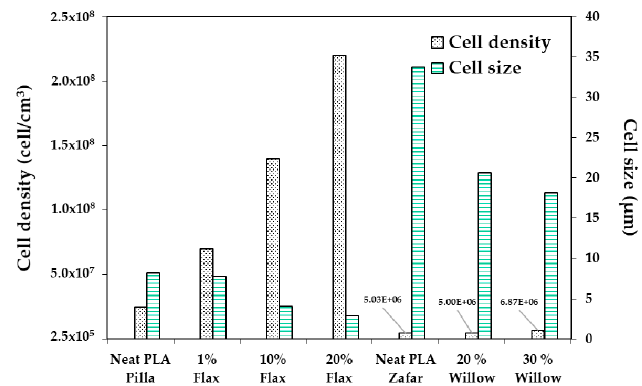
Figure 24. Effects of flax and willow fibers content on PLA foam cell density and cell size. Data taken from Zafar et al. [131] and Pilla et al. [105].